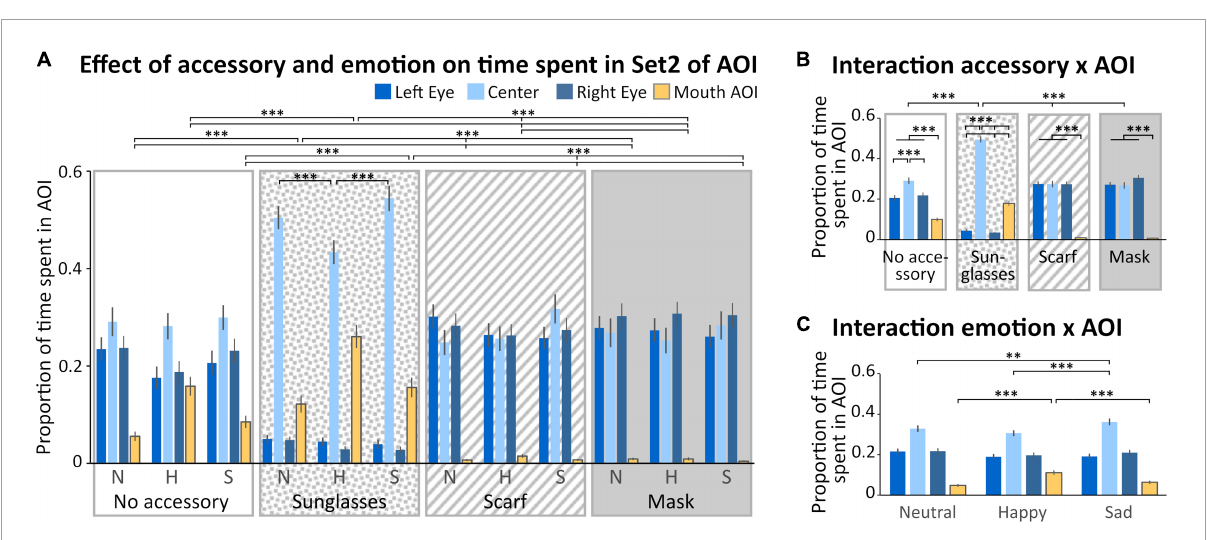
FIGURE4 Analysis of the time spent in Set 2 of AOI. (A) Mean ( ± standard error) of the proportion of time spent (relative to the time spent on the screen) in the Areas of Interest (AOIs) (left eye: medium blue, first columns; center: light blue, second columns; right eye: dark blue, third columns; mouth: yellow, last columns) according to accessory (no accessory: white background; sunglasses: dotted background; scarf: hatched background; mask: gray background) and emotion (neutral: N, happy: H, and sad: S). For sake of clarity, only the significant comparisons for the mouth AOI are illustrated. The pattern is identical for the left and right eyes AOIs, except for the scarf vs mask comparison (see Results section). We also illustrated the comparisons within the sunglasses condition. (B) Mean ( ± standard error) of the proportion of time spent in the AOIs illustrating the accessory × AOI interaction. (C) Mean ( ± standard error) of the proportion of time spent in the AOIs illustrating the emotion × AOI interaction. ∗∗ p < 0.01; ∗∗∗ p <